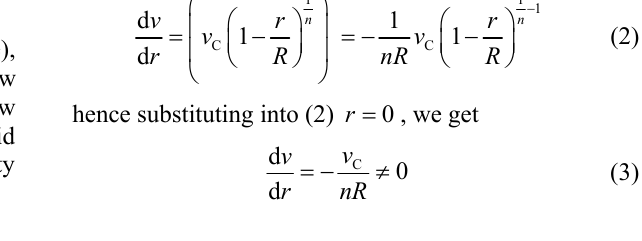
Fig. 1. Average velocity